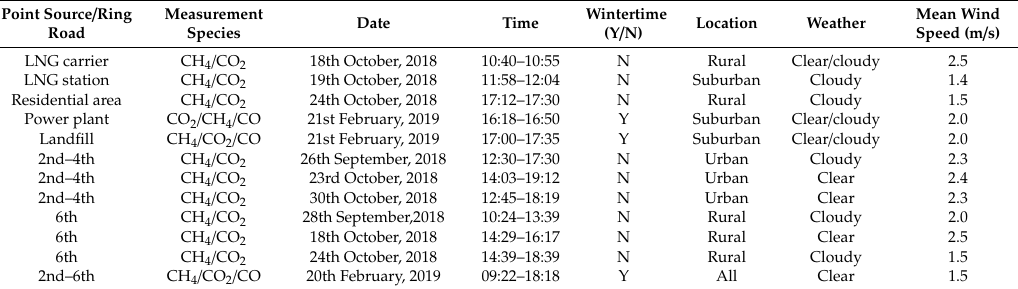
Table 1. Measurement routes and